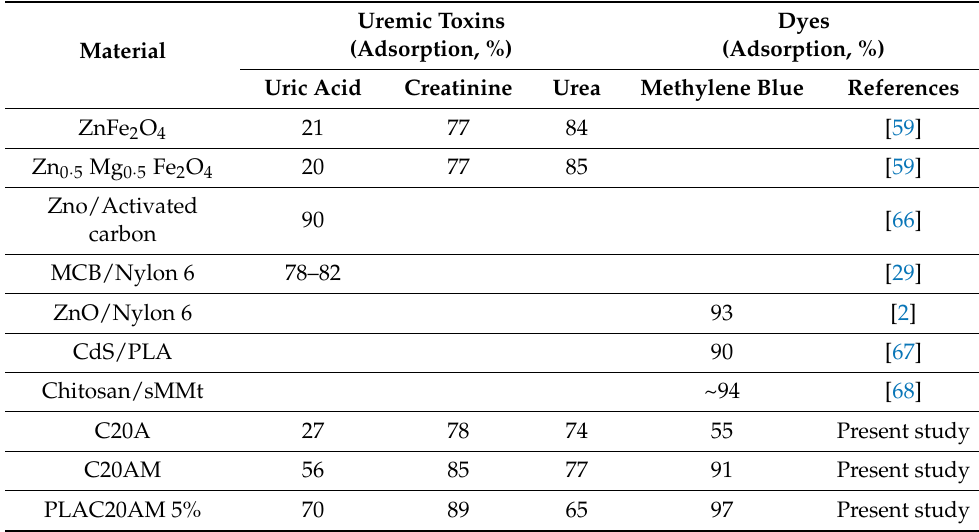
Table 7. Removal percentages of uremic toxins and dyes (adsorption, %).